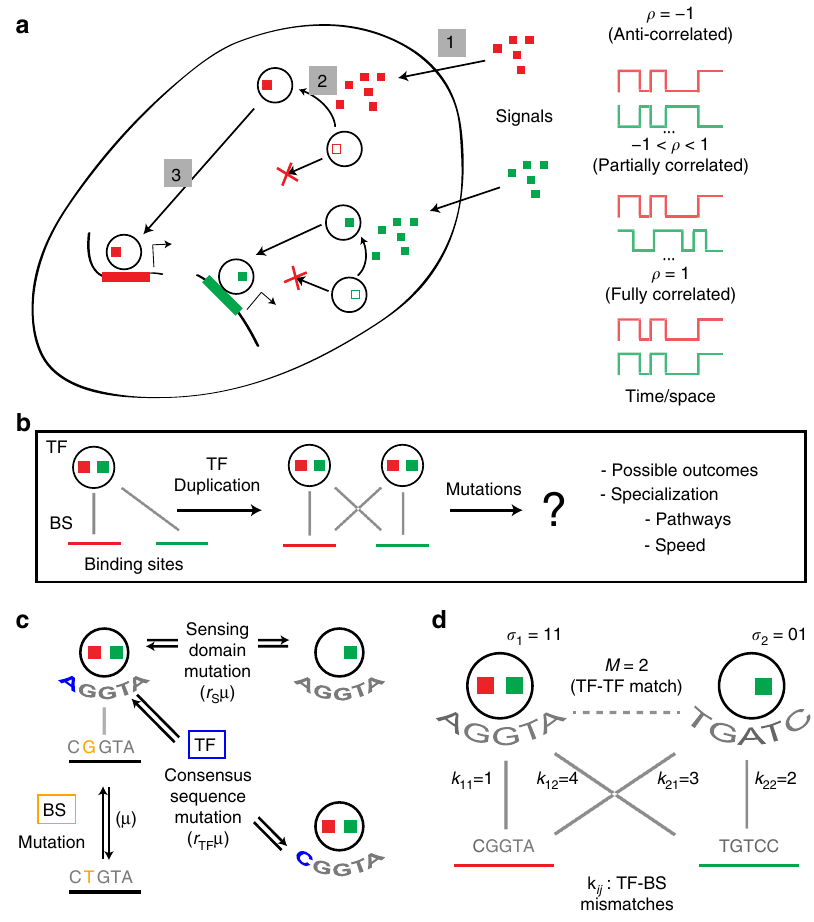
Fig. 1 Schematic of the model. a Simpli fi ed physiology of signal transduction: external signaling molecules ( red and green squares ) are sensed by the cell (1), activate transcription factors inside the cell (2), which in turn activate the corresponding downstream genes (3). The temporal/spatial appearance of the two external signals can be correlated to different extent, as measured by correlation coef fi cient, ρ . These signals can correspond to different time periods in development, spatial regions in the organism or tissue, or external conditions/ligands. b TF, initially responsive to two external signals ( red and green ‘ slots ’ ) and regulating two genes, duplicates and the additional copy fi xes in the population. Immediately after duplication, the two copies are undifferentiated. c Various mutation types that can occur post-duplication with their associated rates. d After accumulating several mutations, the pattern of mismatches between TF consensus sequences and the binding sites is re fl ected in new values of { k ij }, which determine the activation levels of the two genes according to Eq. (1). M , the number of matches between the consensus sequences of the two TFs (with a value between 0 and L ), keeps track of the overall divergence of the TF speci fi cities. For a list of model parameters and baseline values see Supplementary Table